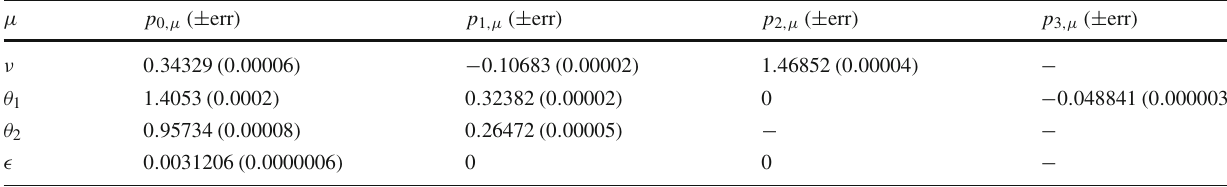
Table 1 Coefficients describing the angular distribution of Cherenkov photons in gamma-ray air showers